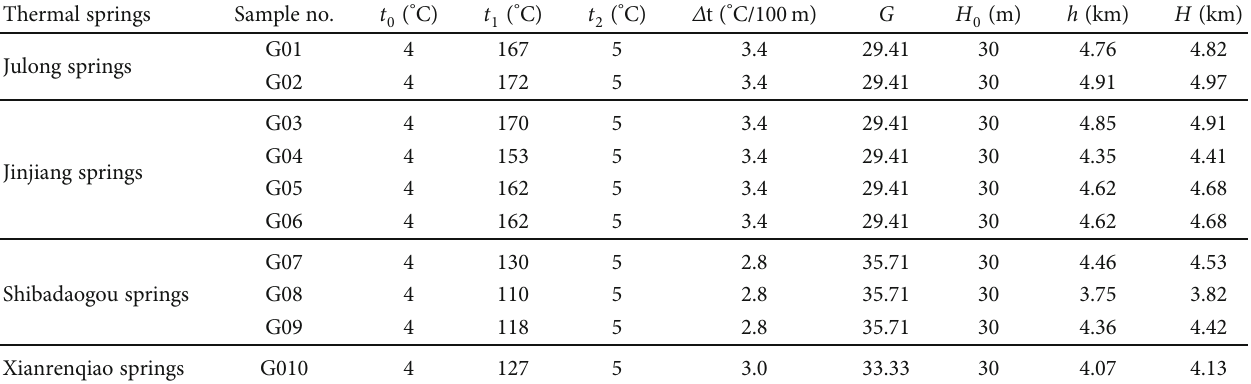
Table 3: Geothermal deep circulation characteristics of di ff erent thermal springs in the Changbai Mountain region. Thermal springs Sample